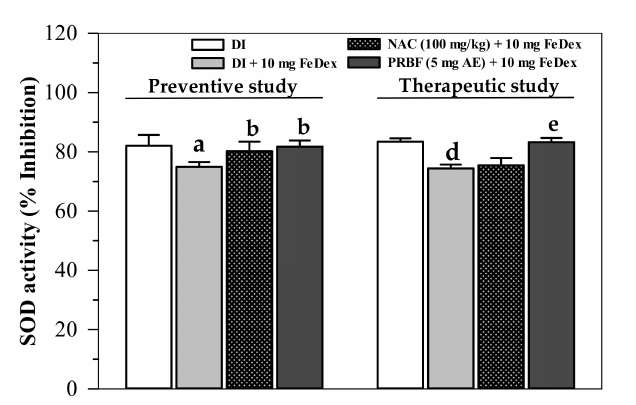
Figure 3. Inhibition of erythrocyte SOD activity in FeDex-loaded mice that had been treated with DI, NAC and PRBF. In the preventive study, mice were treated with DI, NAC (100 mg/kg) and PRBF (5 mg AE/kg) for 14 d. This was followed by a single ip injection with 10 mg FeDex after the last oral dose was administered on day 14. Mice were then sacrificed; their heart blood was collected and their erythrocyte SOD activity was determined. Results are presented in an inhibition graph. In the therapeutic study, mice were ip injected with 10 mg of FeDex together with DI, NAC (100 mg/kg) and PRBF (5 mg AE/kg) for 14 d. Mice were then sacrificed, their heart blood was collected and erythrocyte SOD activity was determined. Data are expressed as mean ± SD values ( n = 6). a p < 0.05 when compared with DI and b p < 0.05 when compared with DI in FeDex loaded mice in the preventive study; d p < 0.05 when compared with DI and e p < 0.05 when compared with DI in Fe-Dex loaded mice in the therapeutic study. Abbreviations: AE = anthocyanin equivalent, PRBF = plasma-treated Riceberry™ rice flour, DI = deionized water, FeDex = iron dextran, NAC = N -acetylcystein, SD = standard deviation, SOD = superoxide dismutase.